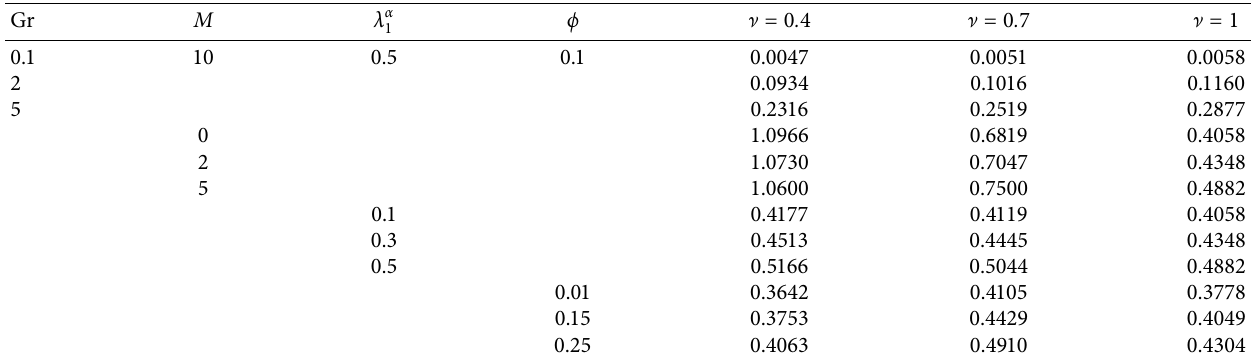
� 0 . 1 , Pr � 6 . 8 , M ∗ � 0 . 5 , and Re � 10. 2